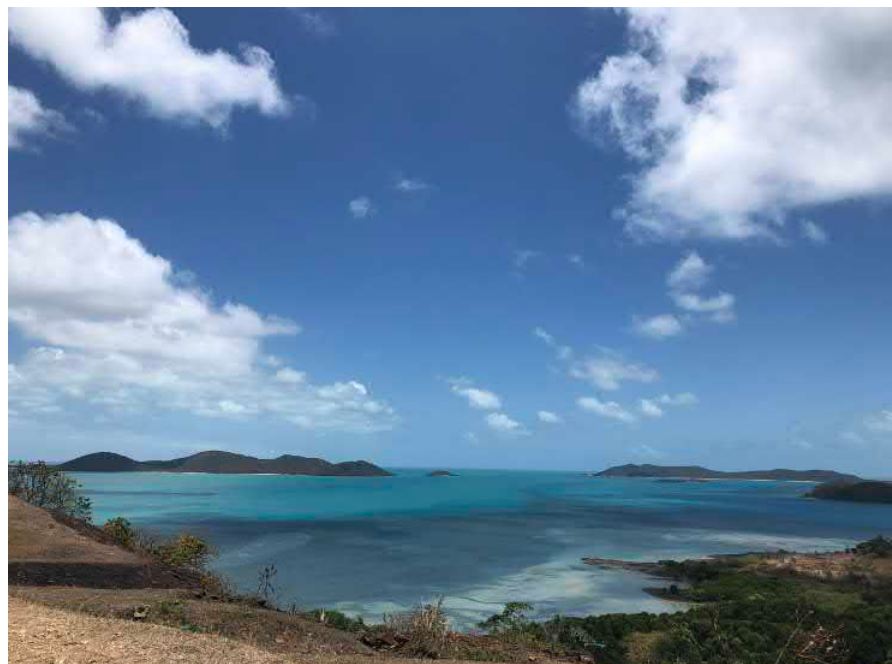
Figure 11: Torres Strait Islands. (Photo: Anna